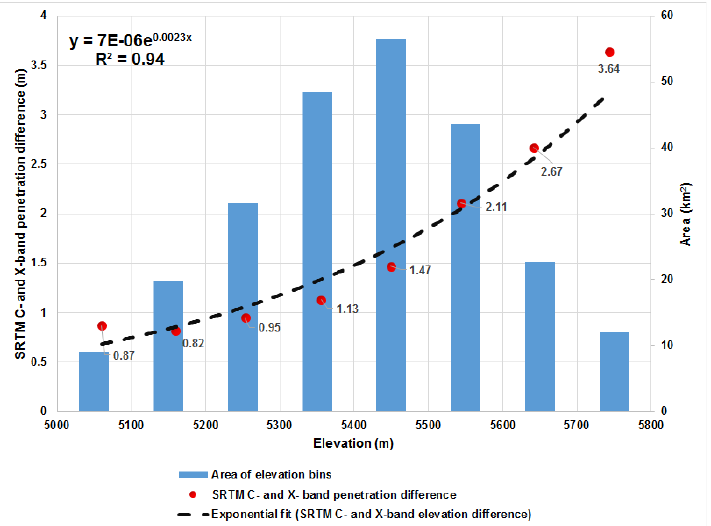
Figure 2. Hypsometric plot of the observed SRTM C- and X- band penetration difference (SRTM-X elevation minus SRTM-C elevations) (red dots) over clean ice/firn/snow in the area represented by a black dashed rectangle in Figure 3. These observations are exponentially fit (black dotted) with a function y = 7E-06e 0.0023 x and R 2 value of 0.94. Here, ( y ) represents the SRTM C- and X-band penetration difference over clean ice/firn/snow and ( x ) is the elevation. Blue columns show the corresponding area (km 2 ) where X- and C- band penetration differences are